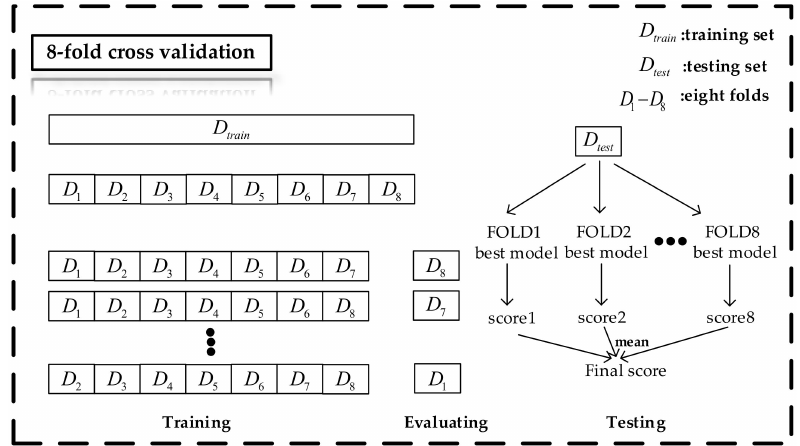
Figure 9. Eight-fold cross-validation of experimental data. Training is the process of training the model using the selected hyperparameter in the training set. Evaluating is the process of saving the optimal model based on the validation set’s score. Testing is the process of evaluating the hyperparameters by calculating each folding model’s scores on the test